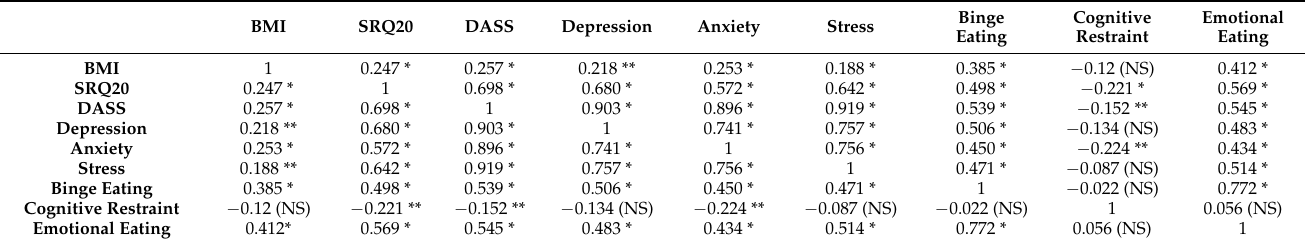
Table 4. Correlations (Spearman’s rho) between behavioral scores.